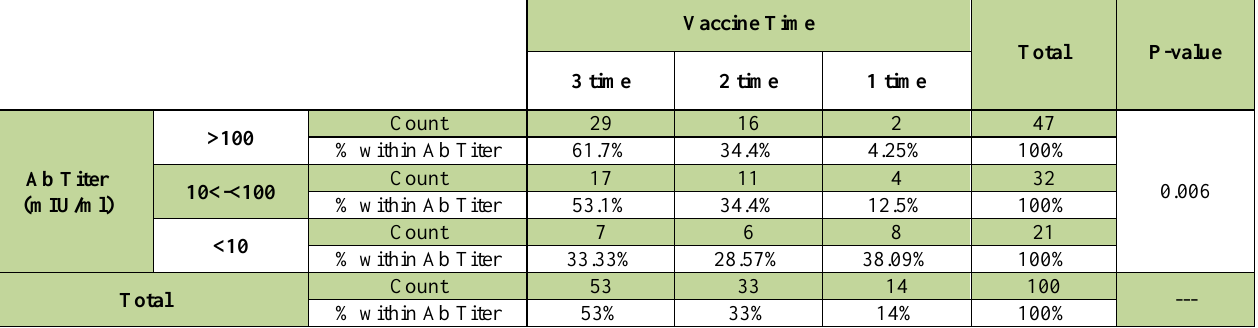
Table 11. Analysis of the relationship between the anti-hepatitis B titration and the number of doses received by the vaccine.